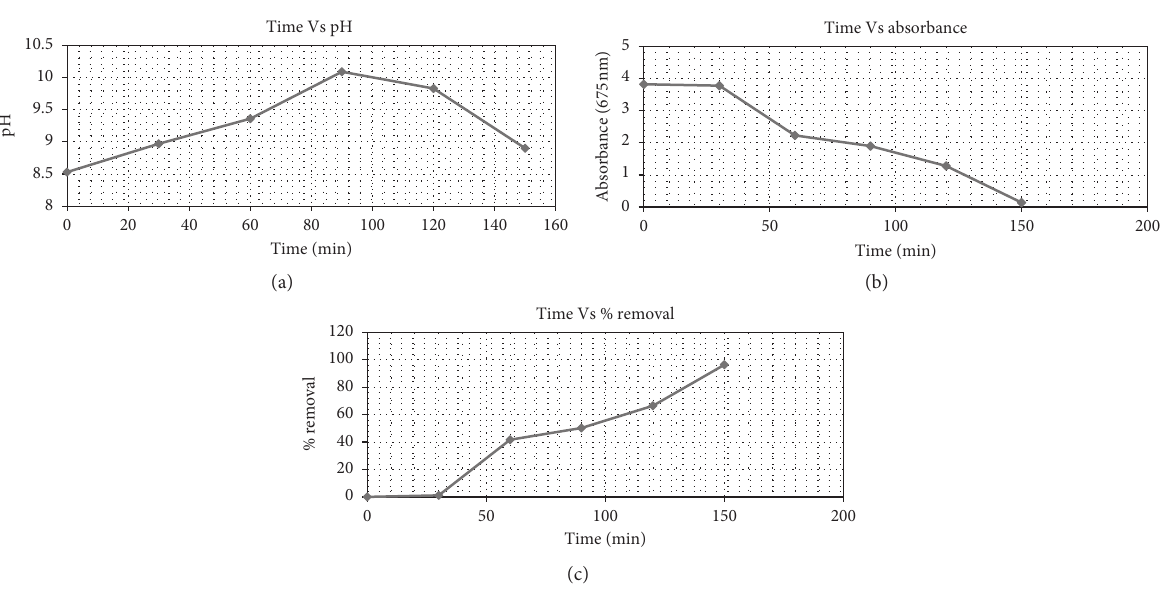
Figure 7: (a) Plot of pH with respect to time over 160min period. (b) Plot of absorbance with respect to time over 200min period. (c) Plot of percent removal with respect to time over 200min period.